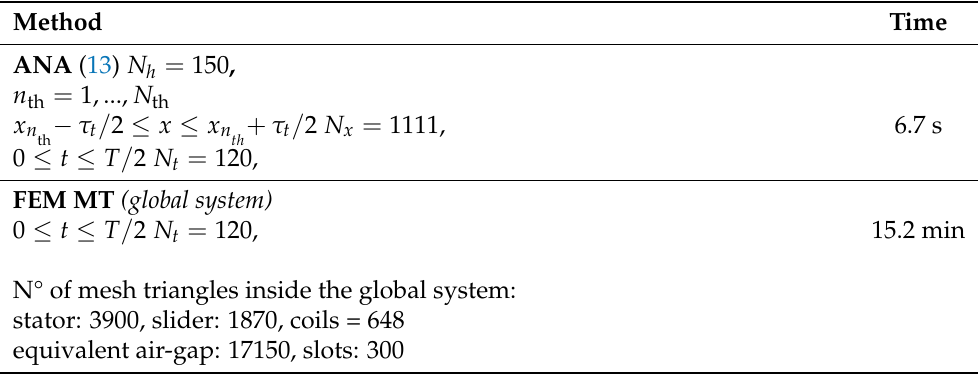
Figure 16. Analytical (continuous lines) and FEM (dotted lines) tooth tip forces per unit length of the slotted machine of Figure 4a, (0 ≤ t ≤ T / 2 N t = 120): ( a ) normal components; ( b ) tangential